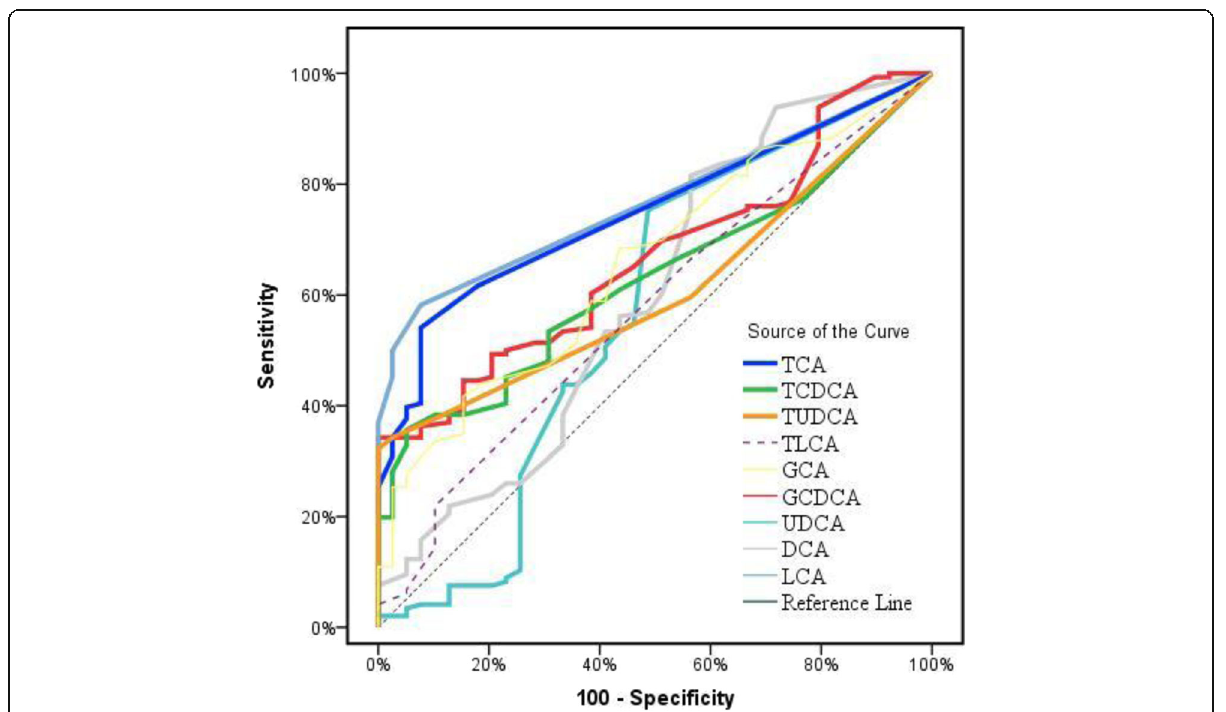
Fig. 1 ROC curve analysis of different bile acids to distinguish viral hepatitis group from NAFLD group